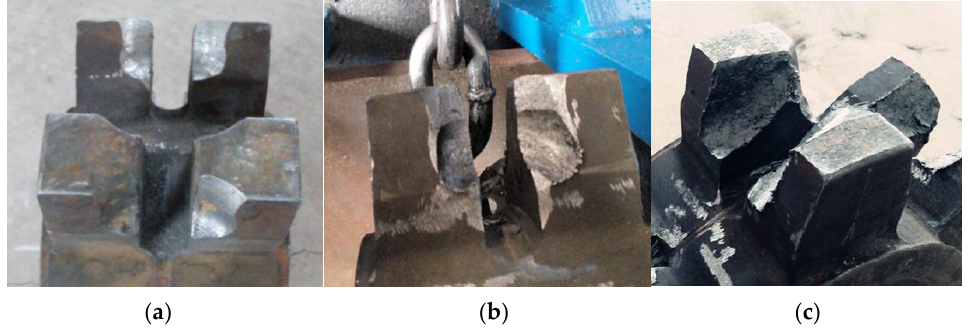
Figure 2. Scraper conveyor sprocket teeth structure shape: ( a ) Before wear; ( b ) After wear; ( c ) After failure. Figure 3a,b show the hardware device’s design, where 1: box; 2: circular track; 3: tooth radial